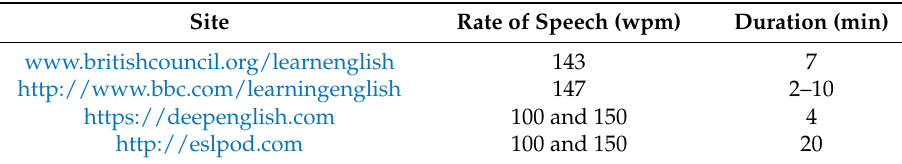
Table 3. The description of the different educational